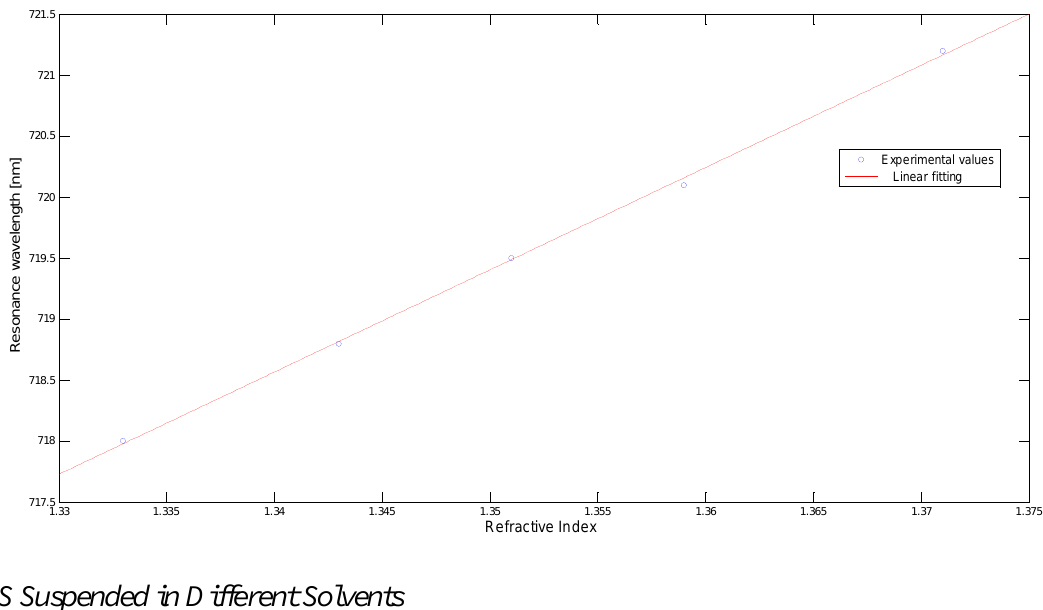
Figure 6. Plasmon resonance wavelength as a function of the refractive index (for LSPR 2), when the gold nanostars are immobilized on the PMMA.